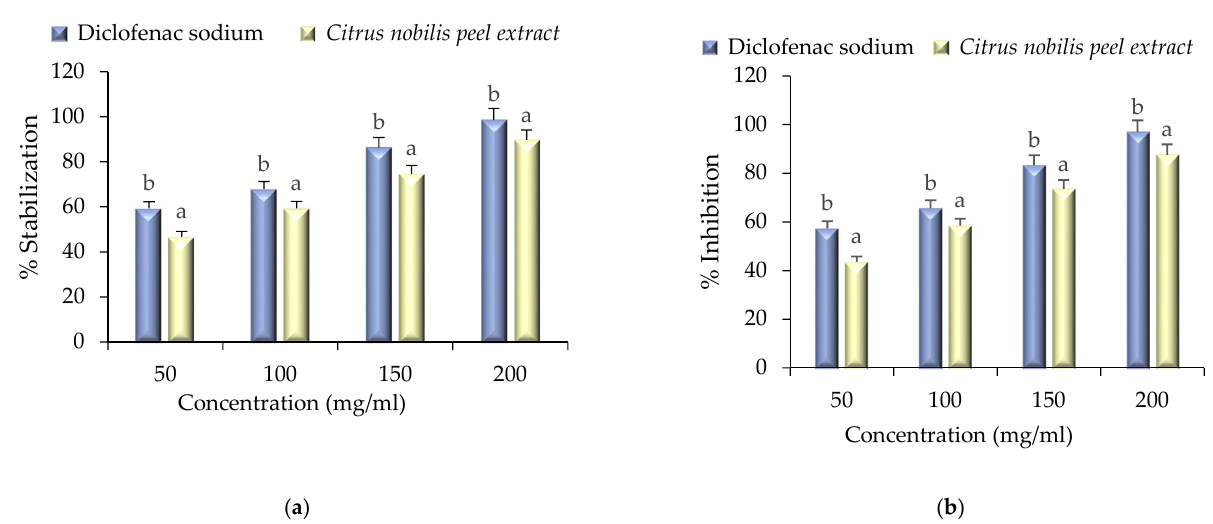
Figure 8. Anti-inflammatory activity of Citrus nobilis peel dry extract during ( a ) HRBC membrane stabilization assay and ( b ) albumin denaturation assay. Data are presented as means ± SEM ( n = 3); a,b: Means within the column with different lowercase superscripts are significantly different ( p < 0.05).